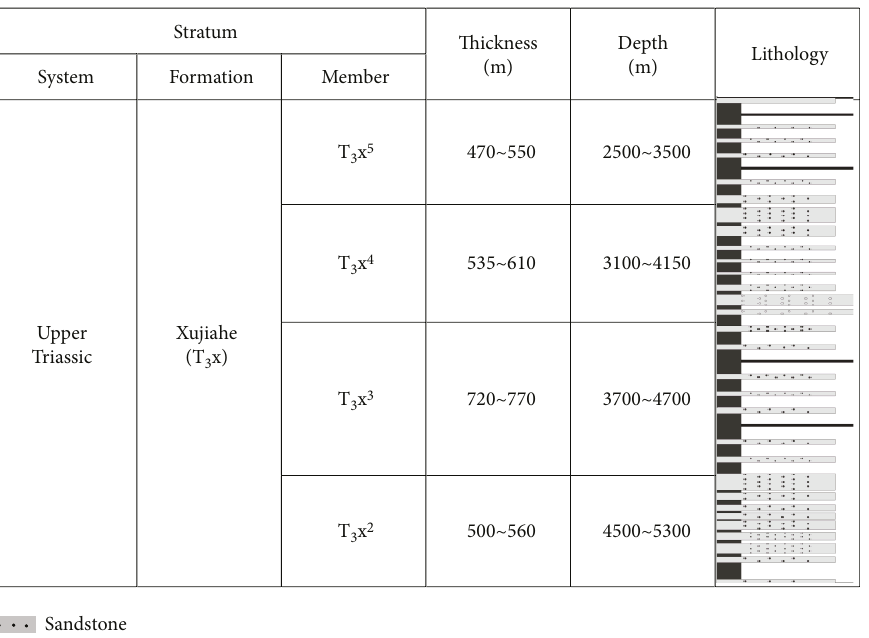
Figure 6: Developing feature of strata in Xujiahe formation, Fenggu area [29]. In late Triassic, a thick set of sediment was deposited in Xujiahe x 2 , T x 3 , T x 4 , and T x 5 members positioned from bottom to top in Fenggu area. formation with T 3 3 3 3